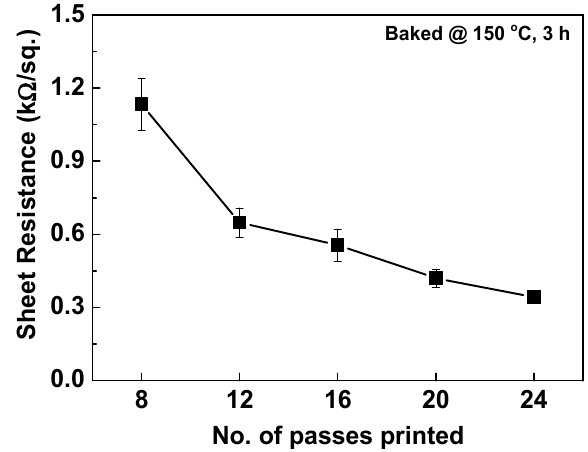
Figure 6. Sheet resistance of 90°-rotated CNT films with respect to the number of printing passes.